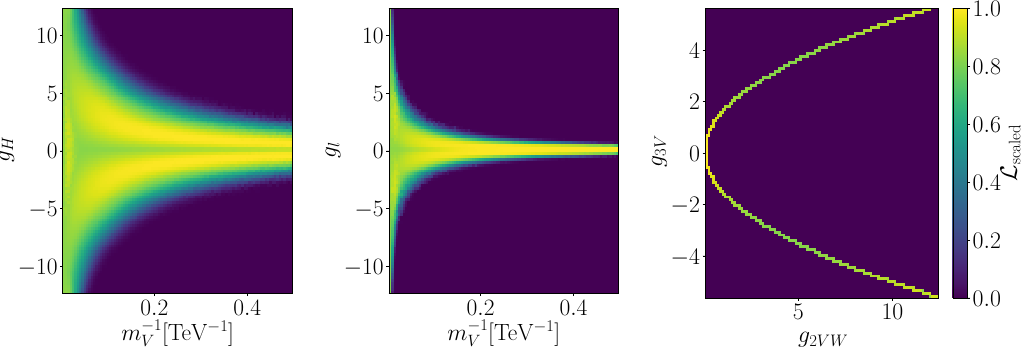
Figure 2: Results of the same global analysis as in Fig. 1, but with measurements set to their actual